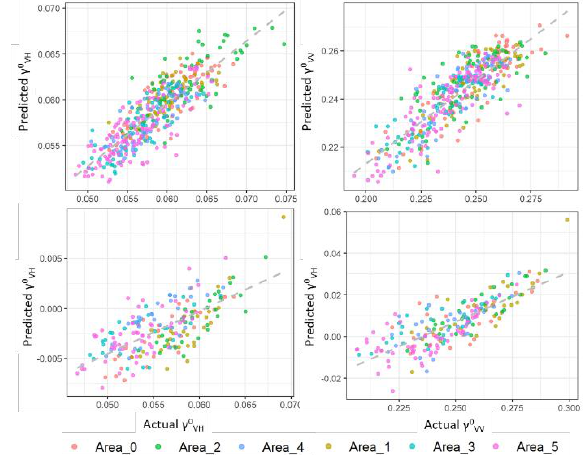
Figure 6. Observed and predicted values. Training dataset (top) and validation dataset